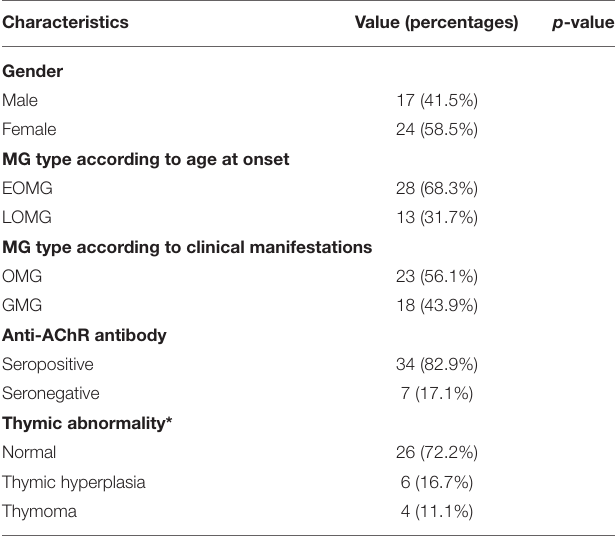
TABLE 2 | Characteristics of the study participants.